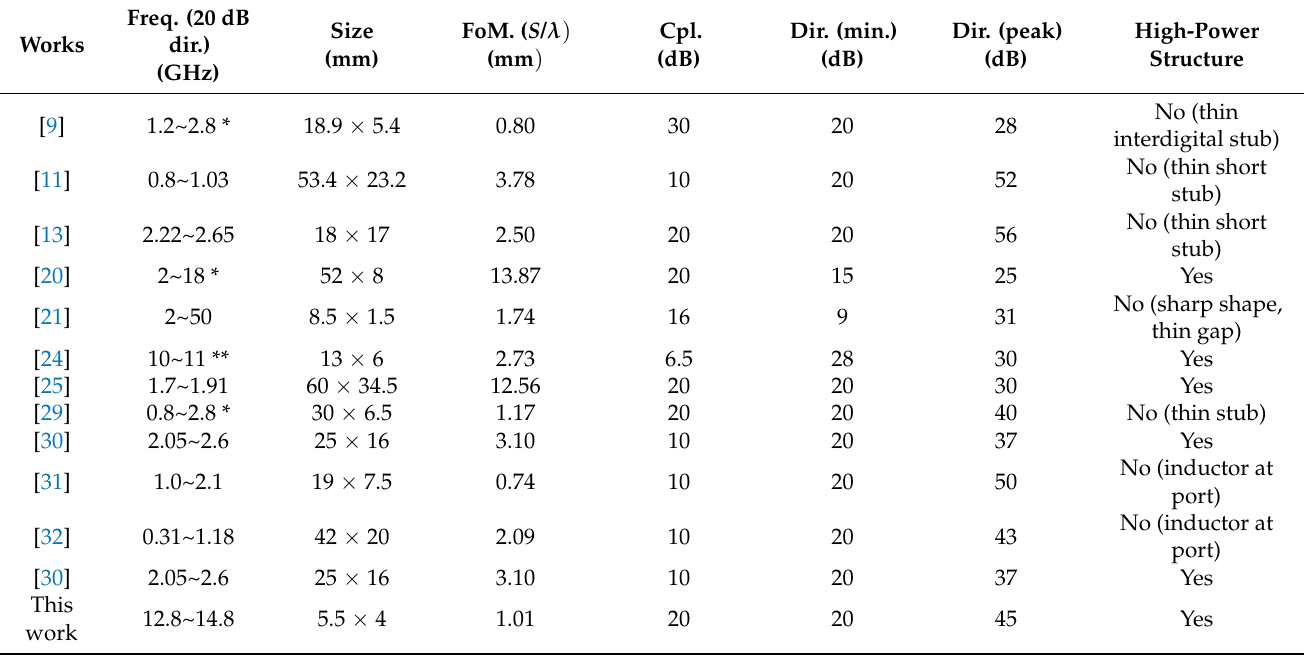
Table 3. Performance